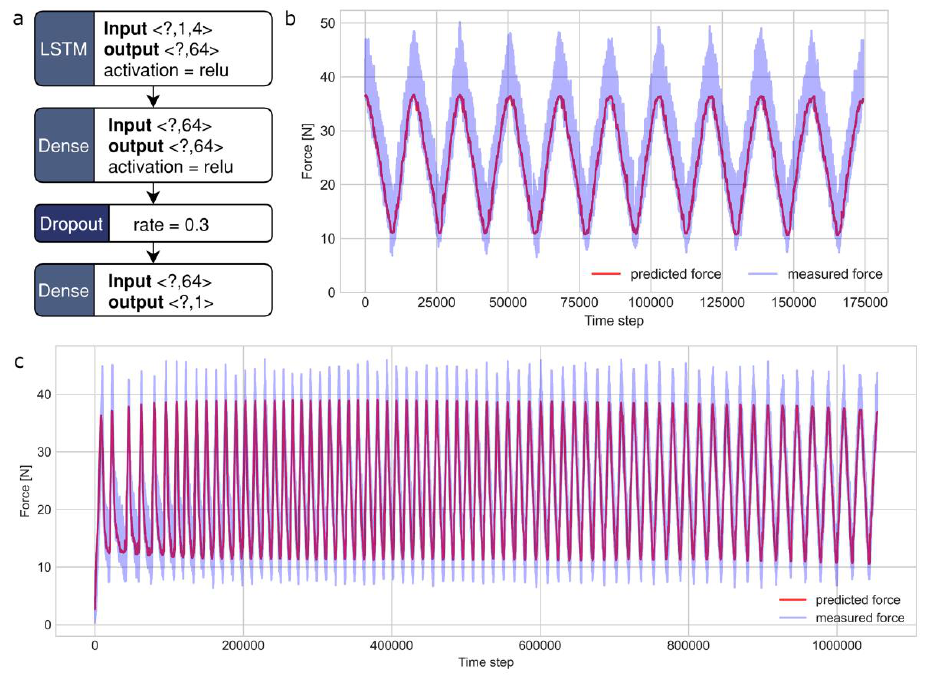
Figure 6. A computational prediction of multi-cyclic behavior of 8 wt.% filler silicone/ethanol material-actuator (uniform multi-cyclic actuation experiment): ( a ) LSTM neural network model, ( b ) actuation force prediction using the model trained on the same specimen (the training, validation and test sets belong to the same specimen), ( c ) cross-specimen prediction (the train and test sets belong to different specimens; here, prediction on one test set).